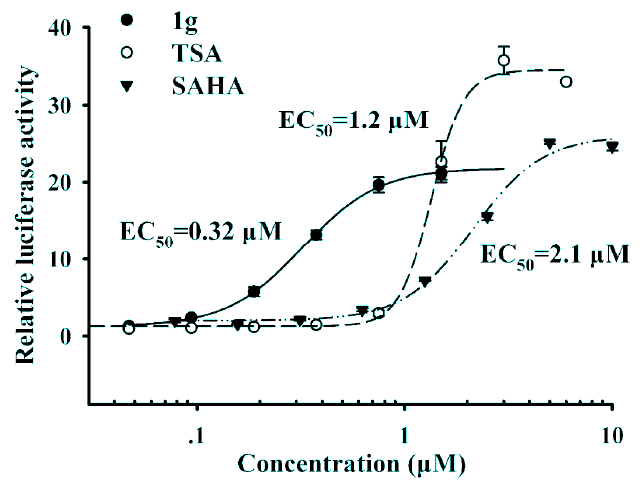
Figure 2. The dose-response curves of compound 1g and SAHA.